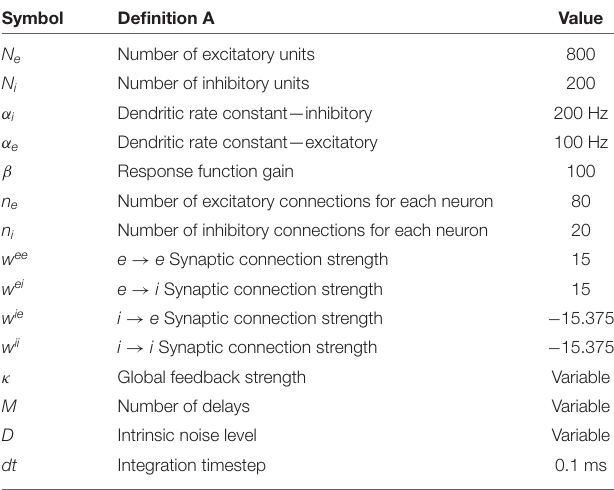
TABLE 1 | Parameters of the two-population